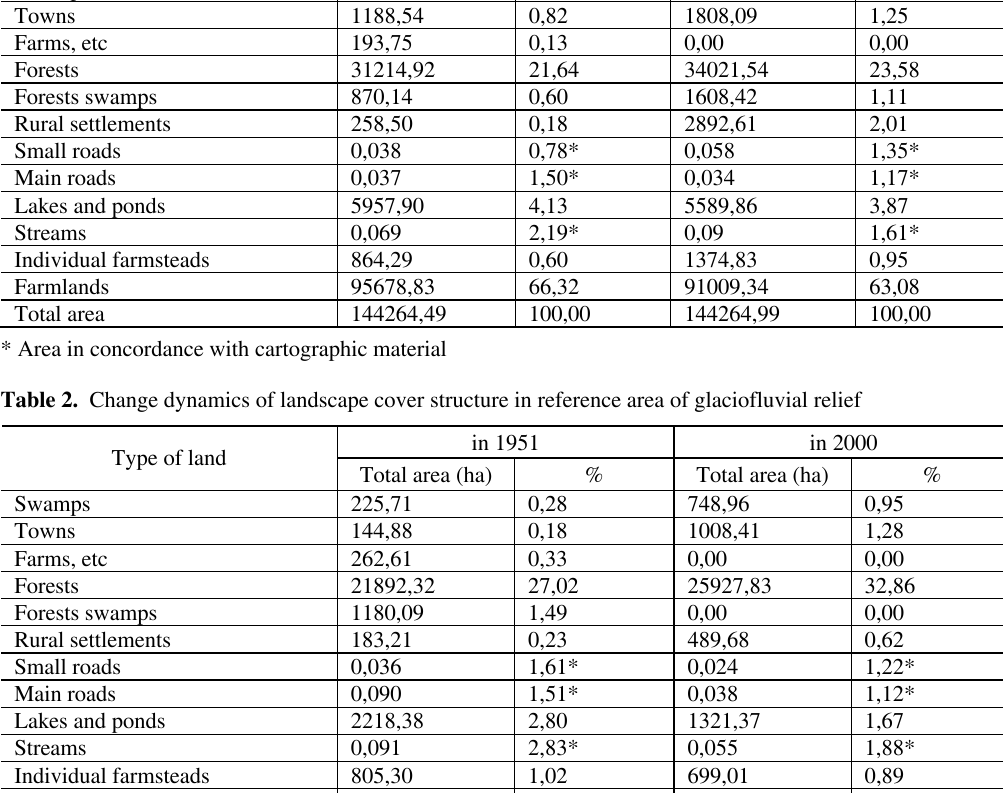
Table 3. Change dynamics of landscape cover structure in reference area of fluvial relief